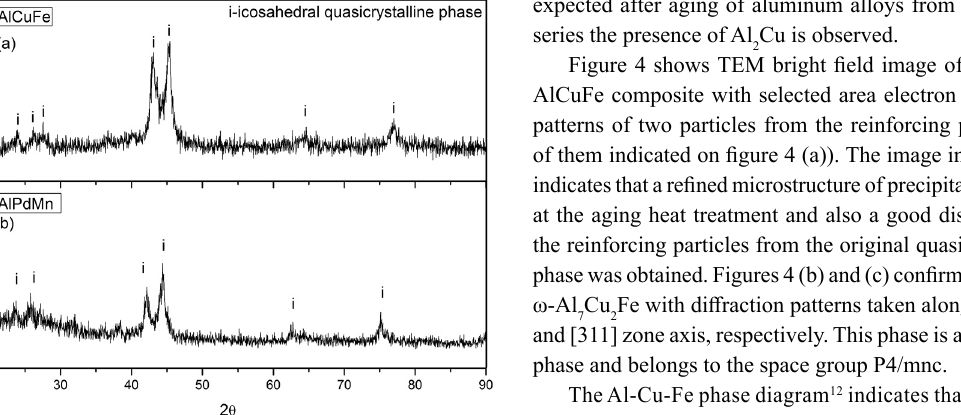
Figure 1: XRD patterns of the annealed Al quasicrystalline reinforcing powders, in (a) and (b), respectively.